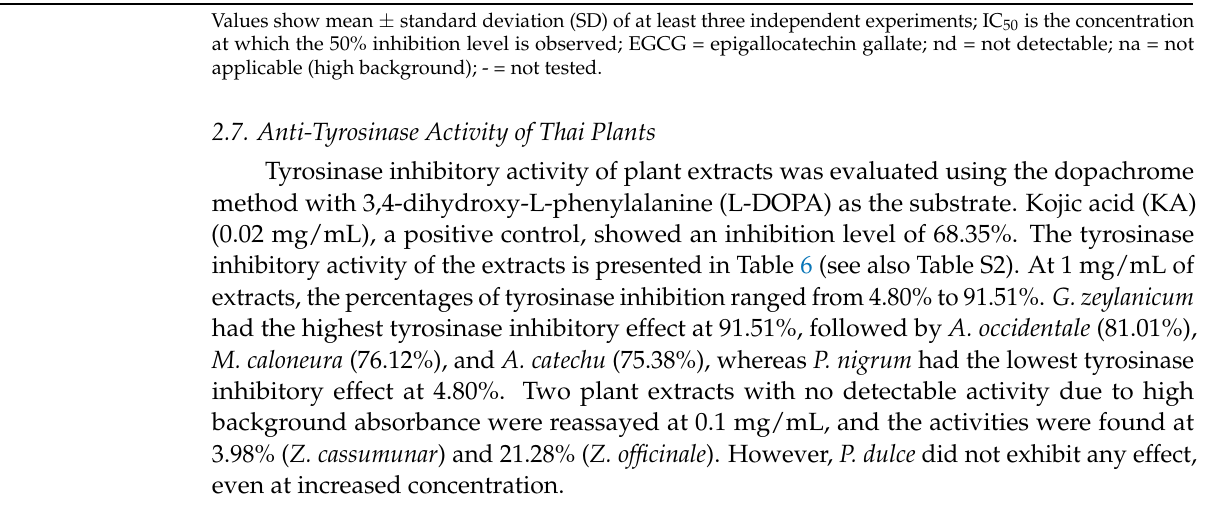
Table 6. Tyrosinase inhibitory activity of Thai